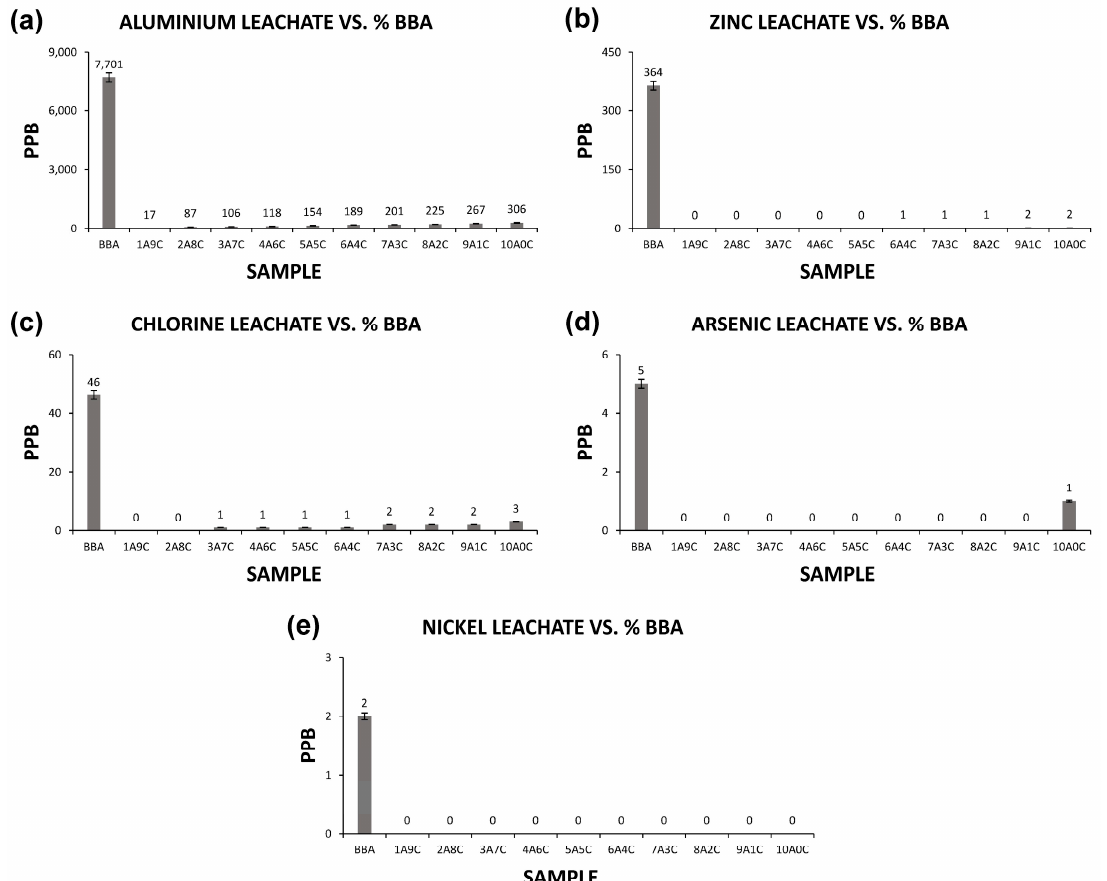
Figure 4. Graphs of the leachates of different chemical elements in the families of ceramic samples and in the unaltered sample of biomass bottom ash. ( a ) aluminium leachates, ( b ) zinc leachates, ( c ) chlorine leachates, ( d ) arsenic leachates and ( e ) nickel leachates.